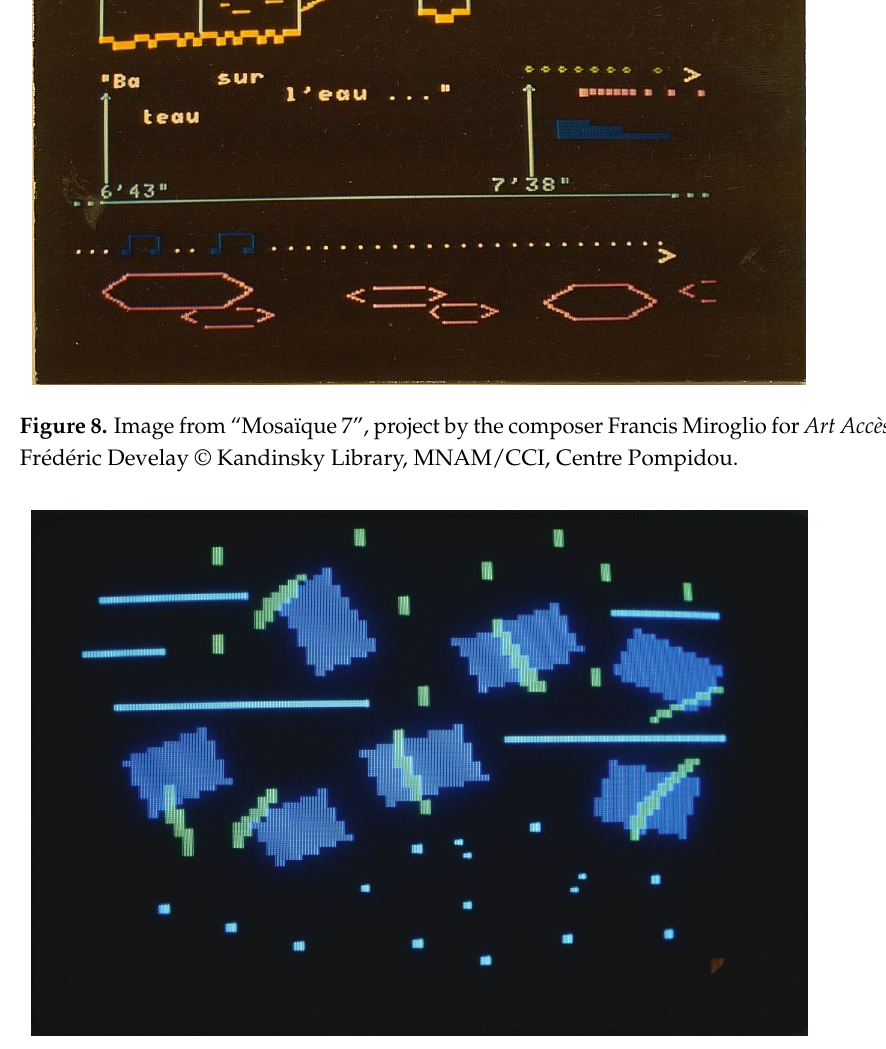
Figure 8. Image from “Mosaïque 7”, project by the composer Francis Miroglio for Art Accès . Collection Frédéric Develay © Kandinsky Library, MNAM/CCI, Centre Pompidou.